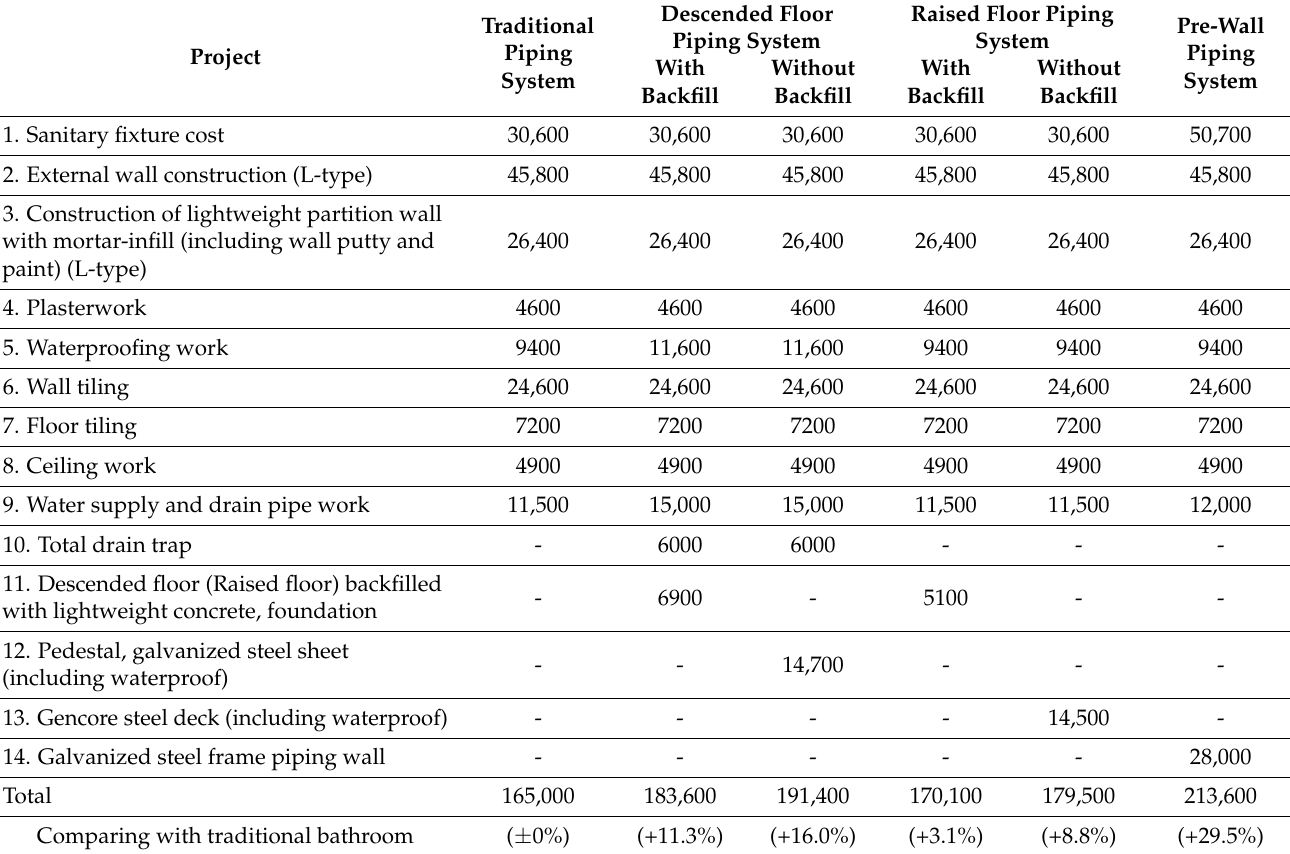
Table 1. Construction initial cost for four types of bathroom piping